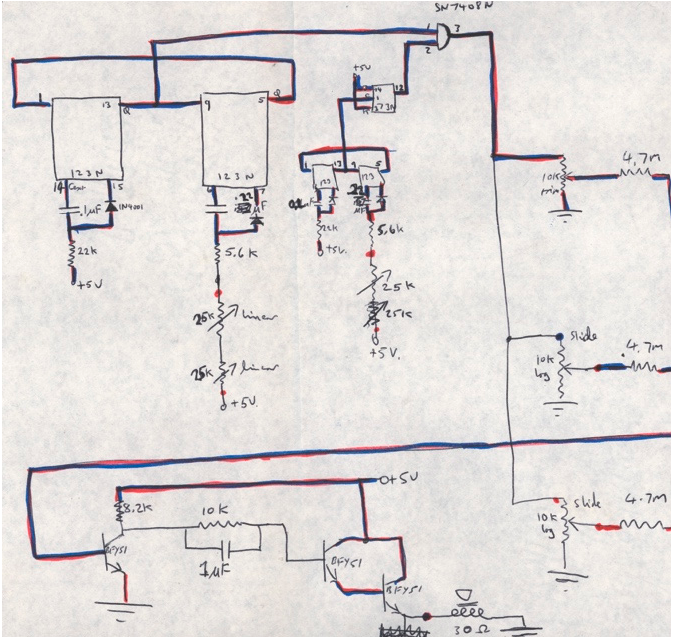
Figure 5. Circuit diagram (detail) of Communications Game with sound output (c. 1972). © Ernest Edmonds.